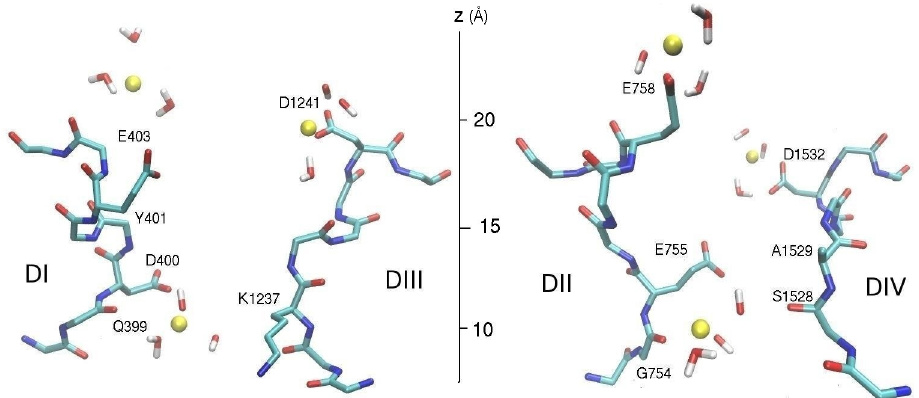
Fig 6. Snapshot of the pore domain of the Na V 1.4 model depicting Na + ions. One Na + ion is in the SF at z = 9.7 Å , and two Na + ions are in the vestibule at z = 21.6 and 23.5 Å . The two ions in the vestibule are in off- axis positions and separated by about 11 Å . The domains DI and DIII (left) and DII and DIV (right) are shown separately for clarity.